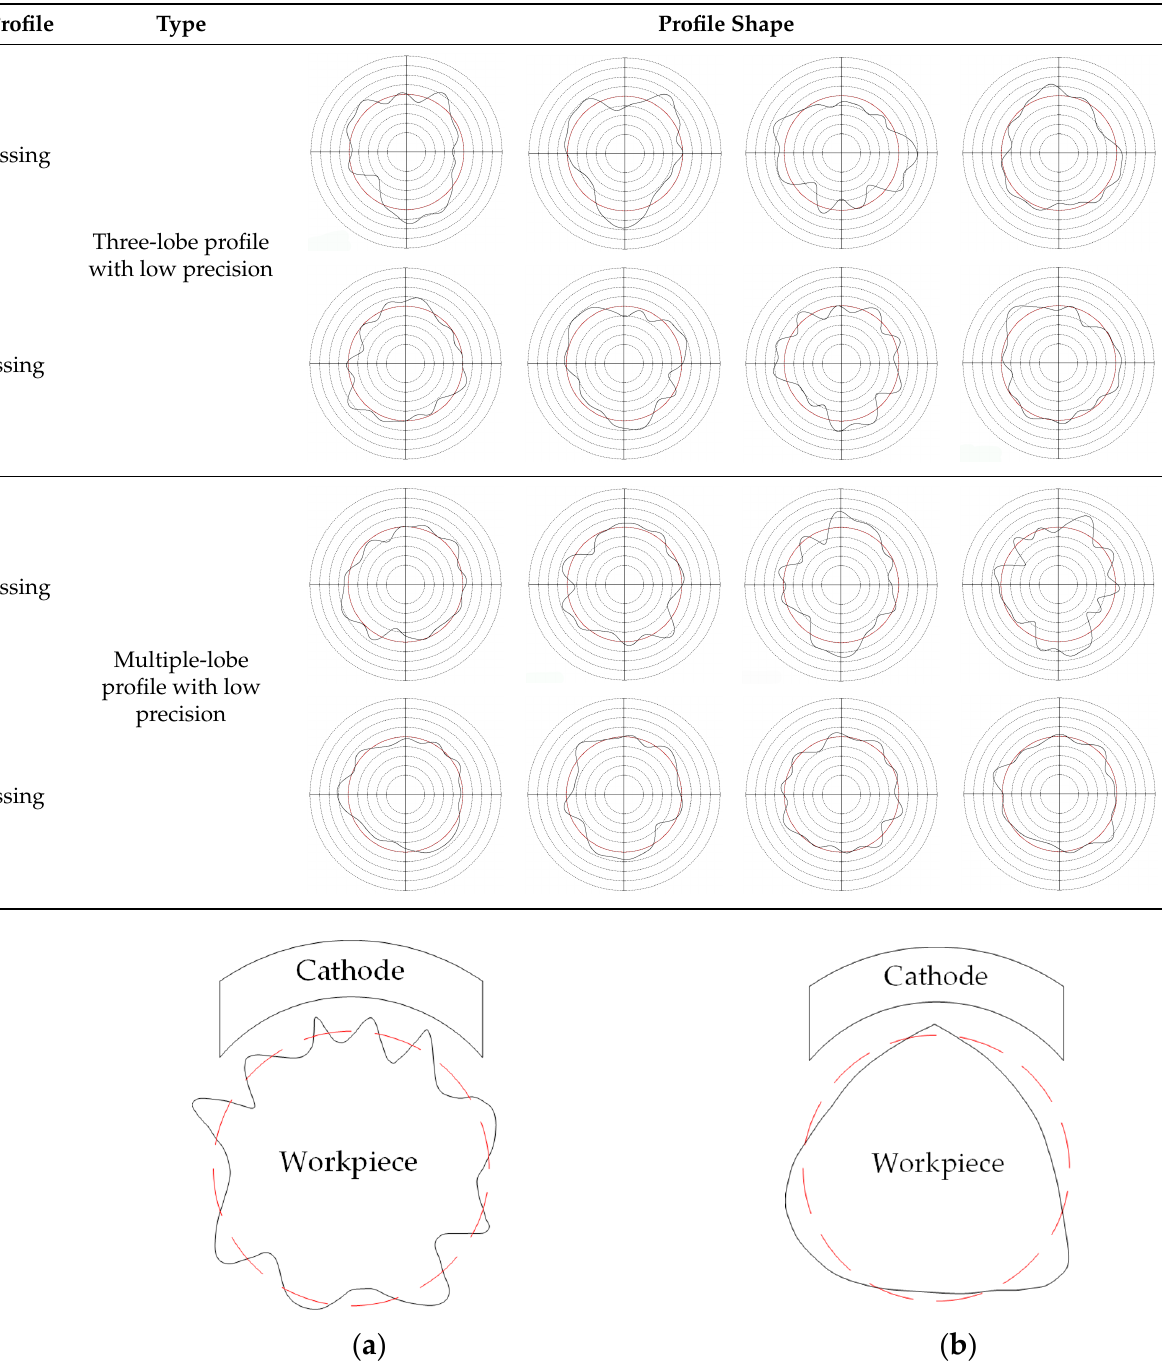
Figure 10. Error correction under different profile shapes: ( a ) multiple-lobe profile; ( b ) three-lobe profile. Table 12. Profile shape before and after processing under 30° cathode coverage.